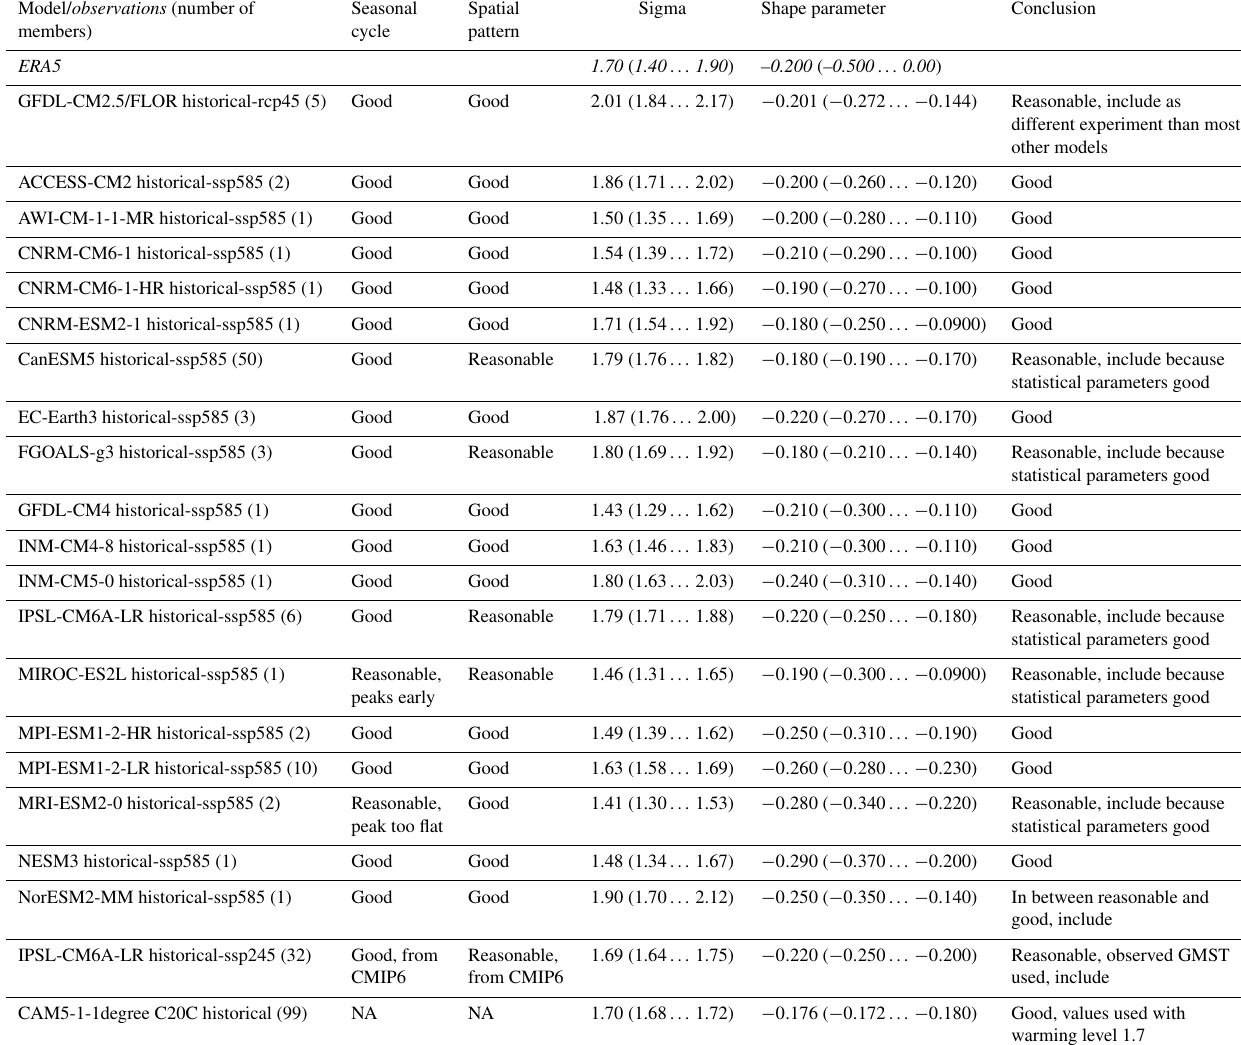
Table 1. Validation results for models that passed the validation tests on seasonal cycle, spatial pattern, and fitted GEV scale parameter and shape parameter ( σ ). Observations in